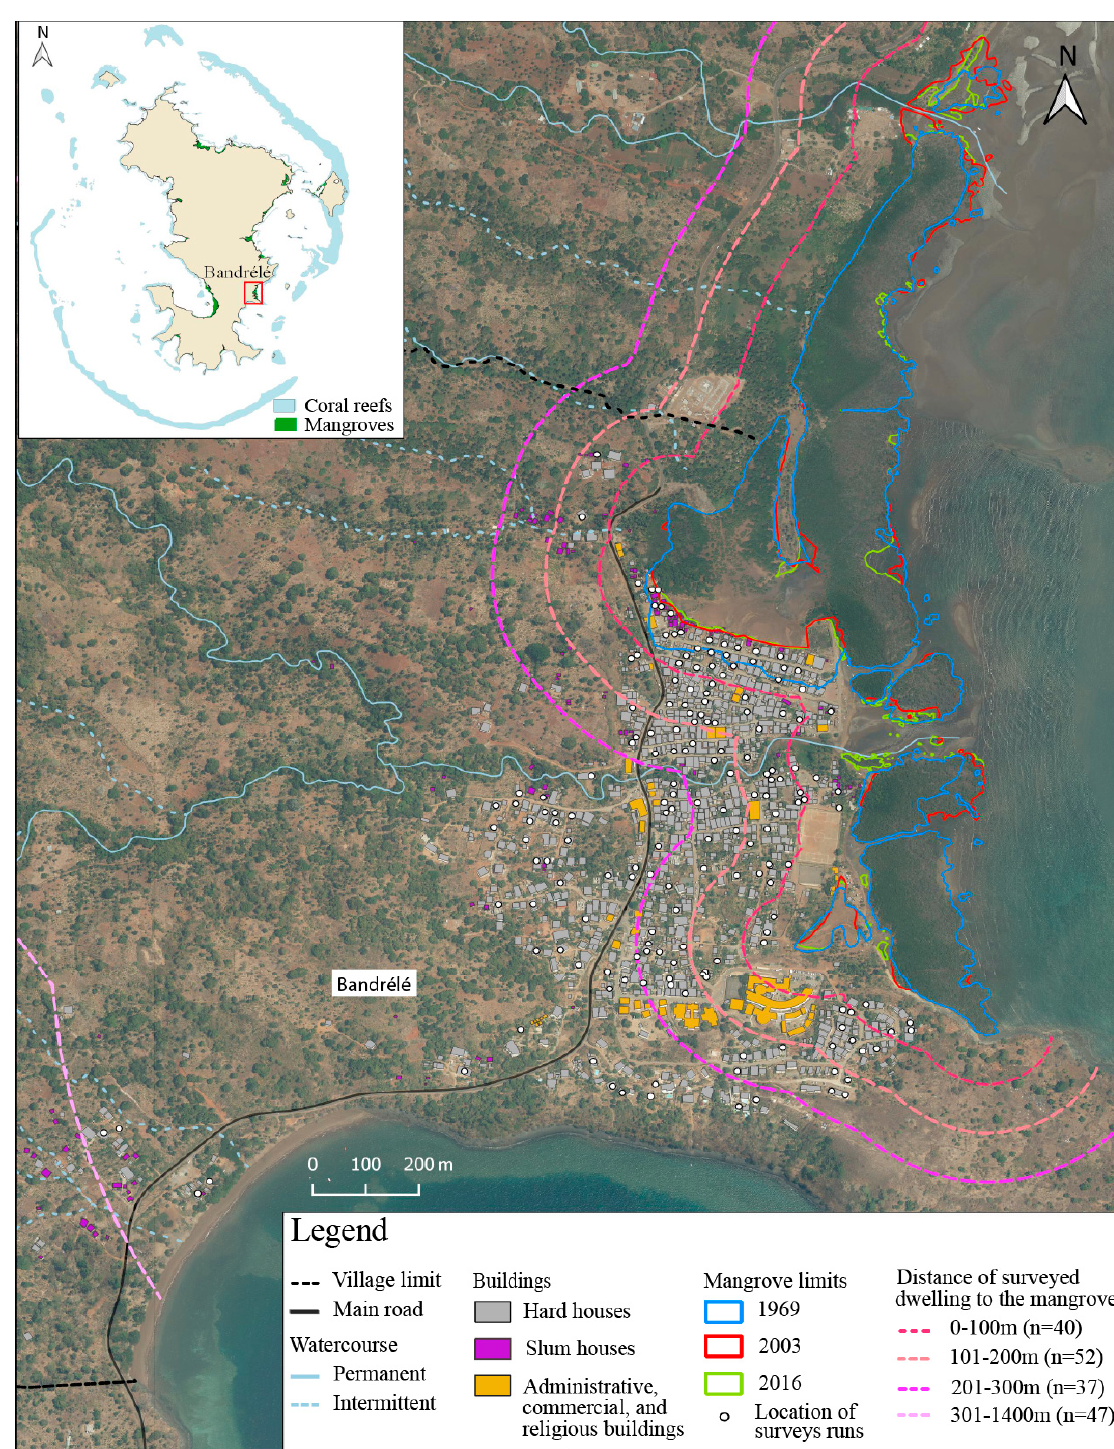
Figure 2. Map of the surface evolution of the Bandrélé mangrove and the village of Bandrélé. Sources: aerial photographs: IGN 2016; cartographic data: BD topo ® IGN ; mangrove limits: [40].